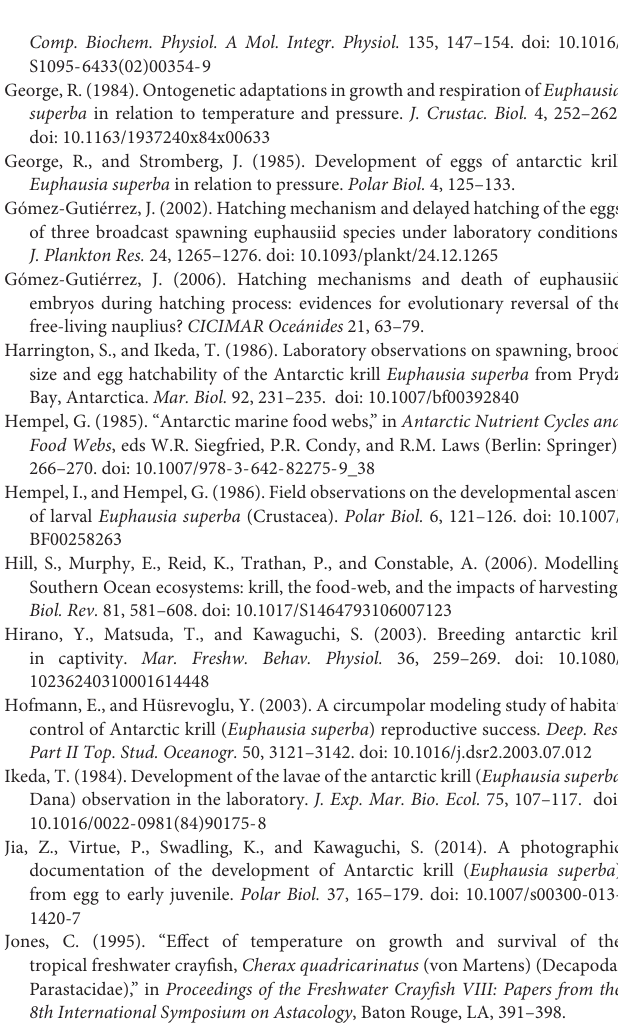
FIGURE S1 | A schematic showing our field experiment setup. For each batch of eggs ( > 1000) produced by a gravid female the following experimental setup was used. We placed ∼ 60 eggs into each of nine treatment bottles. Three bottles were placed in each of the three temperature treatments. Each day ∼ 30 eggs were removed from each of the bottles and fixed in 4% formalin. FIGURE S2 | Recorded stages of embryonic development from field experiments. Photographic documentation for the different embryonic development stages recorded when analyzing the eggs from the field experiment in the